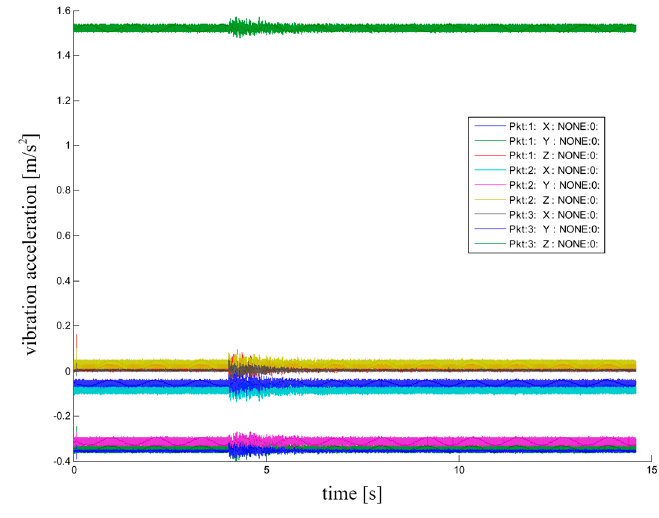
Figure 5. System responses at all the available measurement points. System responses at all the available measurement points are presented in Figure 5. From the point of view of the best signal-to-noise ratio, the third measurement point and the OX direction were selected.